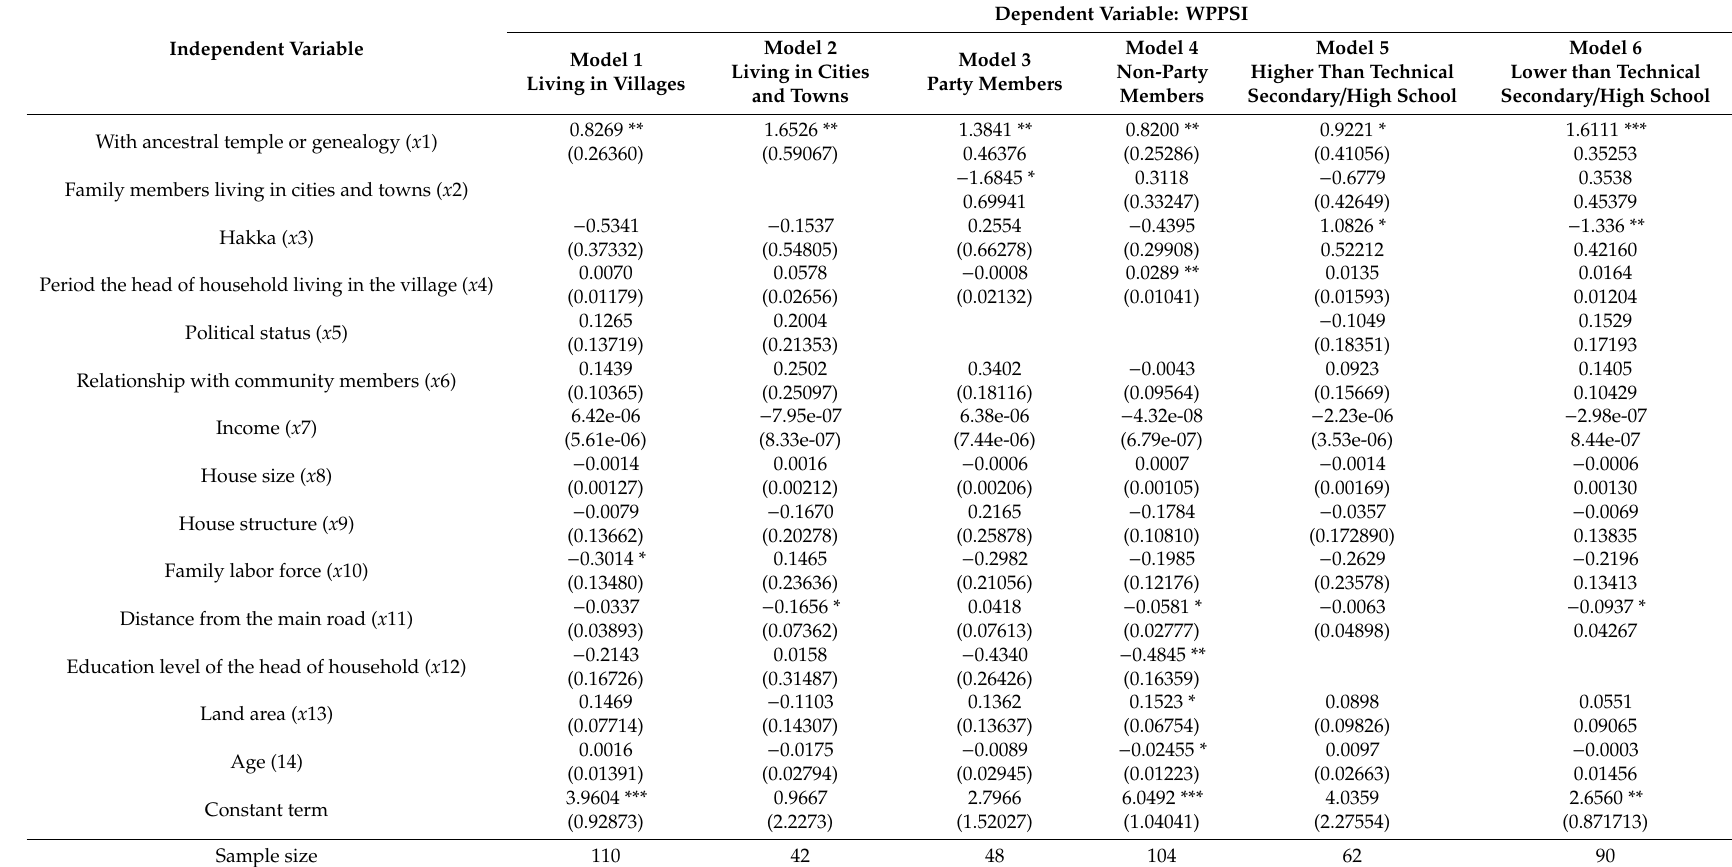
Table 5. Group regression results of Tobit model for robustness